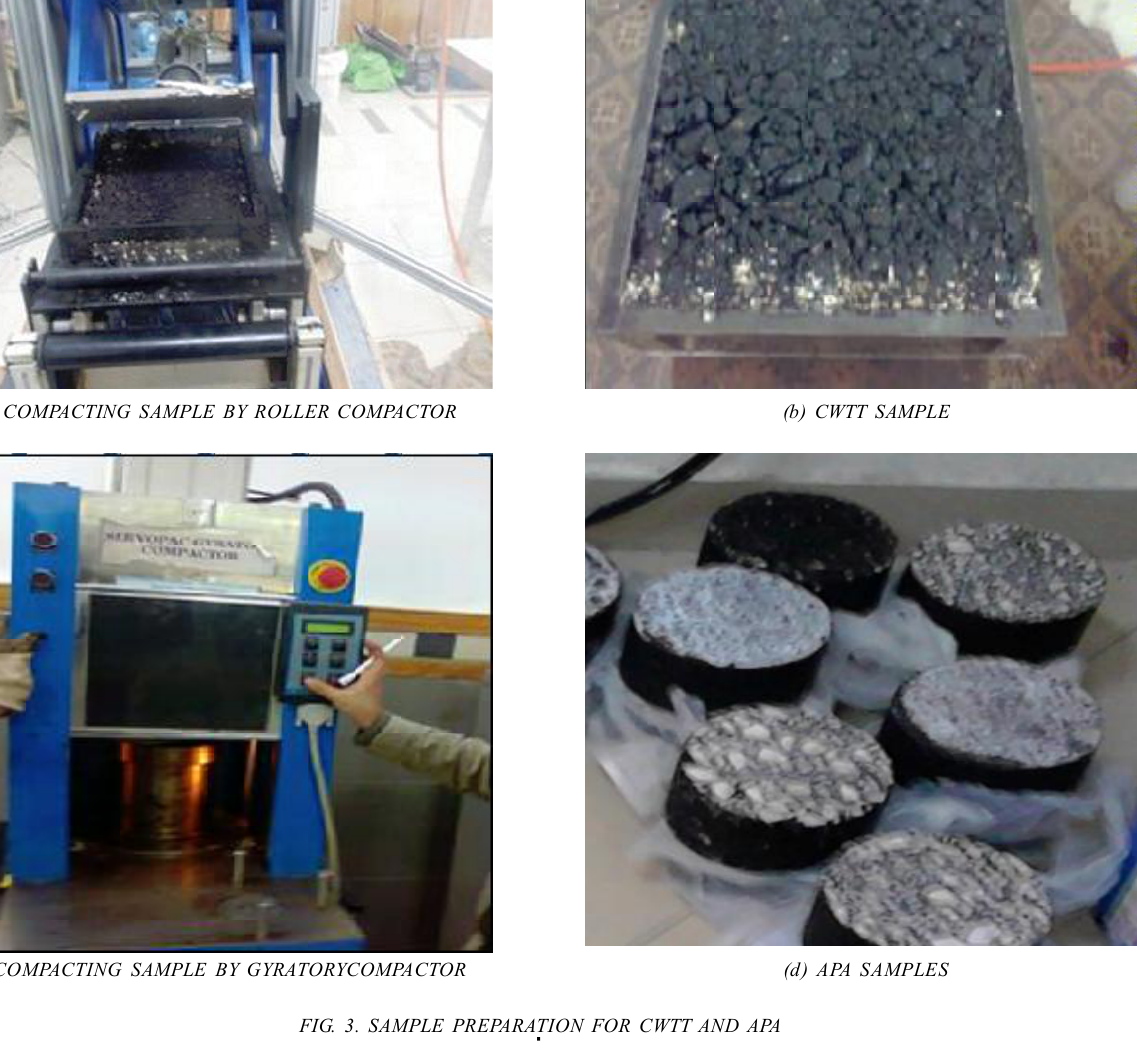
FIG. 3. SAMPLE PREPARATION FOR CWTT AND